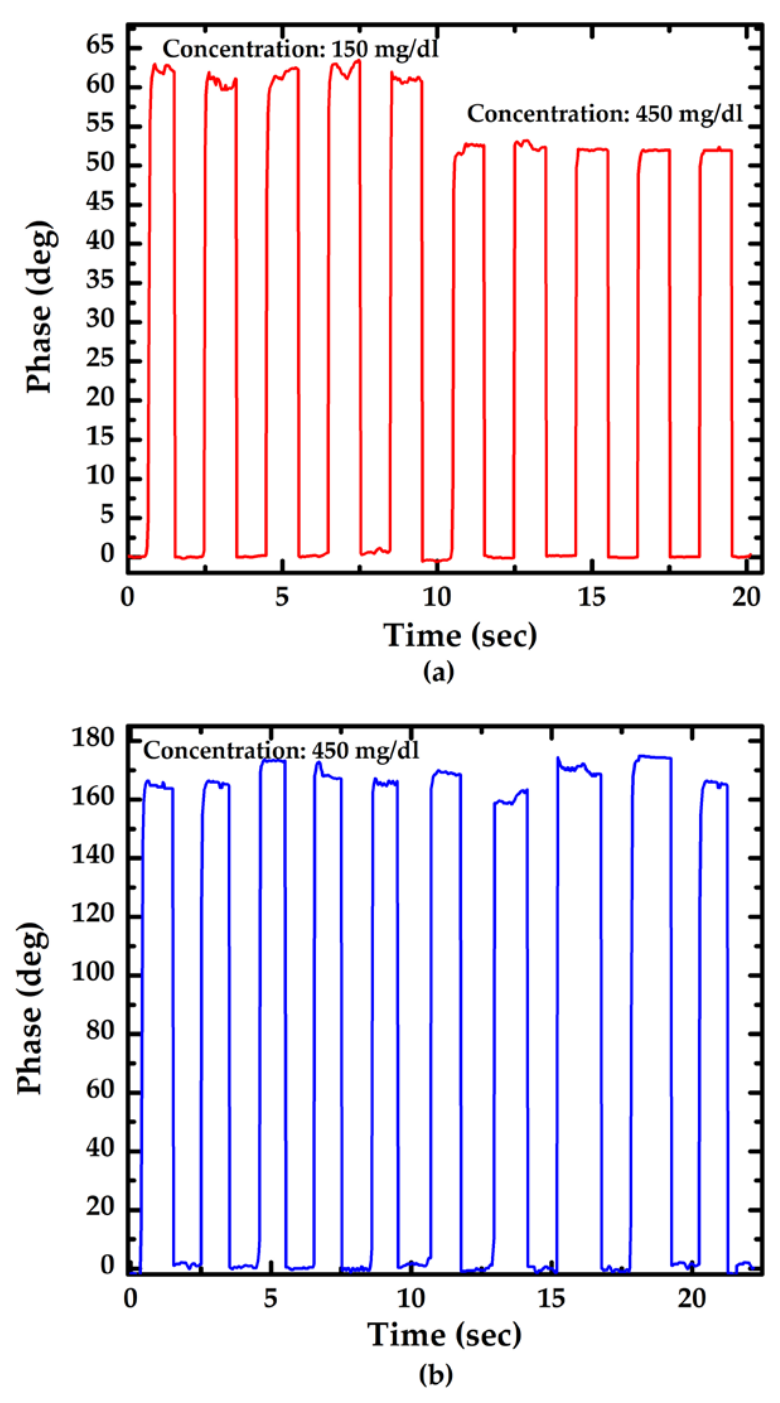
Figure 6. Repeatability evaluation of the sensor with various length of the sensor: ( a ) 1 cm; ( b ) 3 cm.